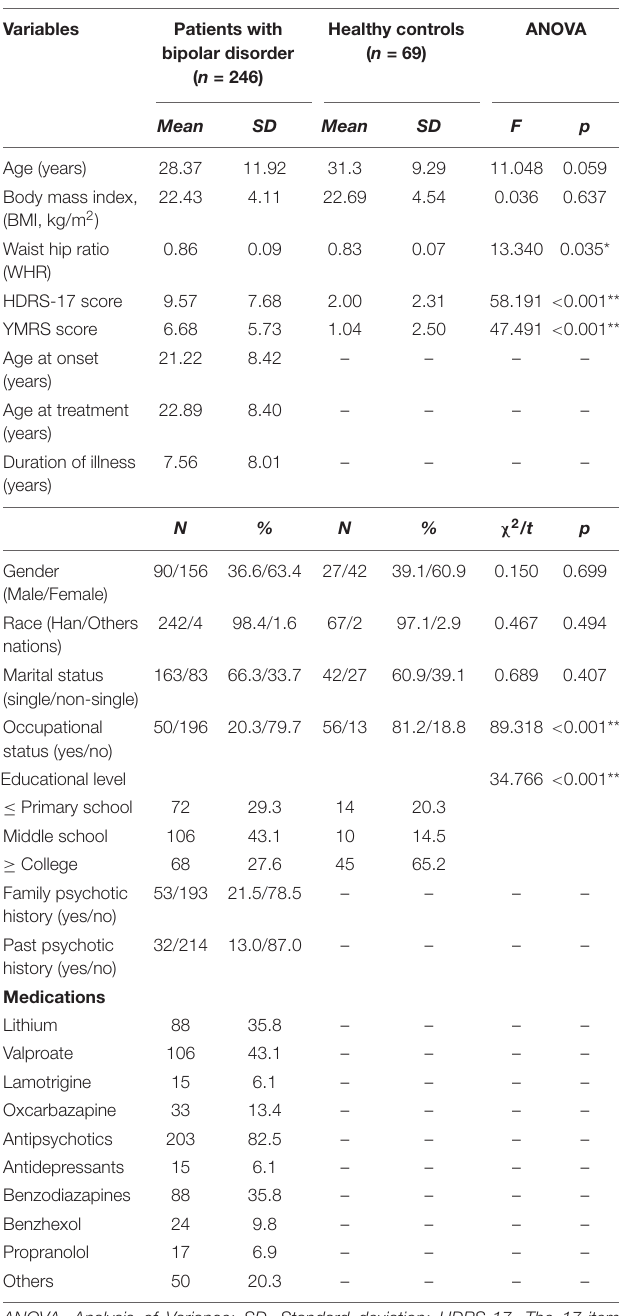
TABLE 1 | Demographic, clinical and pharmacological characteristics in patients with bipolar disorder and healthy